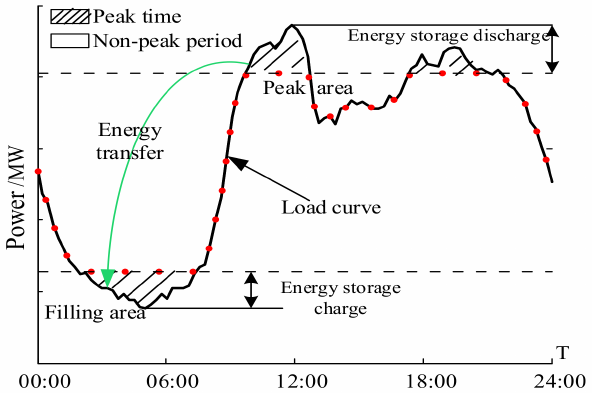
Figure 1. Schematic diagram of ES peak regulation.